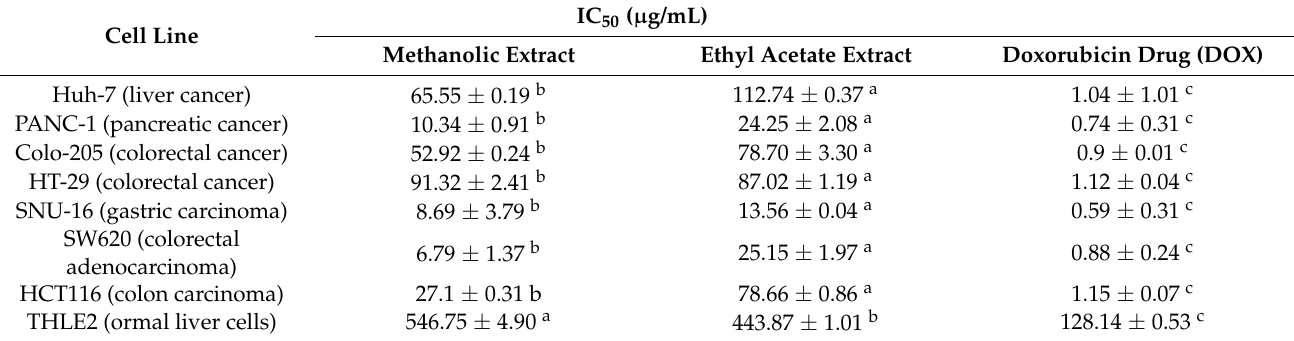
Table 9. IC 50 of ethyl acetate and methanolic extracts of mature fruits (K m ) of K. pinnata .